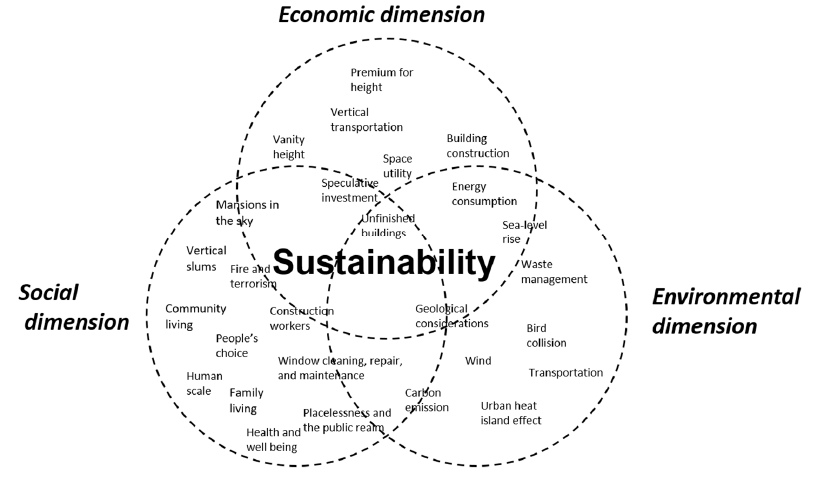
Figure 1. Using “Sustainability” as a guiding framework to organize the many issues related to tall building developments.